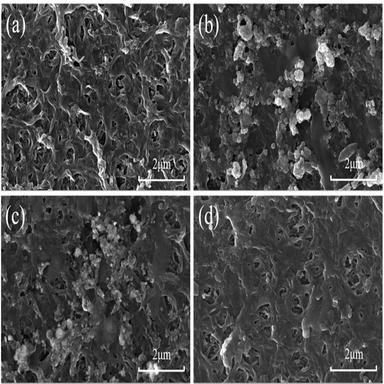
Scanning electron micrographs: (a) Virgin membrane, (b) Membrane fouled by ROC, (c) Membrane fouled by ROC pretreated with AOPs-UF, (d) Mixed cleaned membrane.